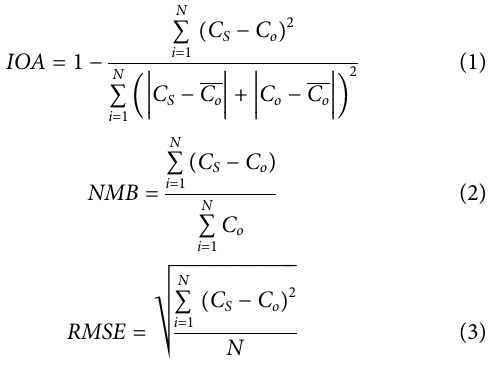
algorithm based on geometry-dependent surface Lambertian equivalent re fl ectivity (Lamsal et al., 2020). For AOD, the quality of the data was improved by (van den Oord et al.,